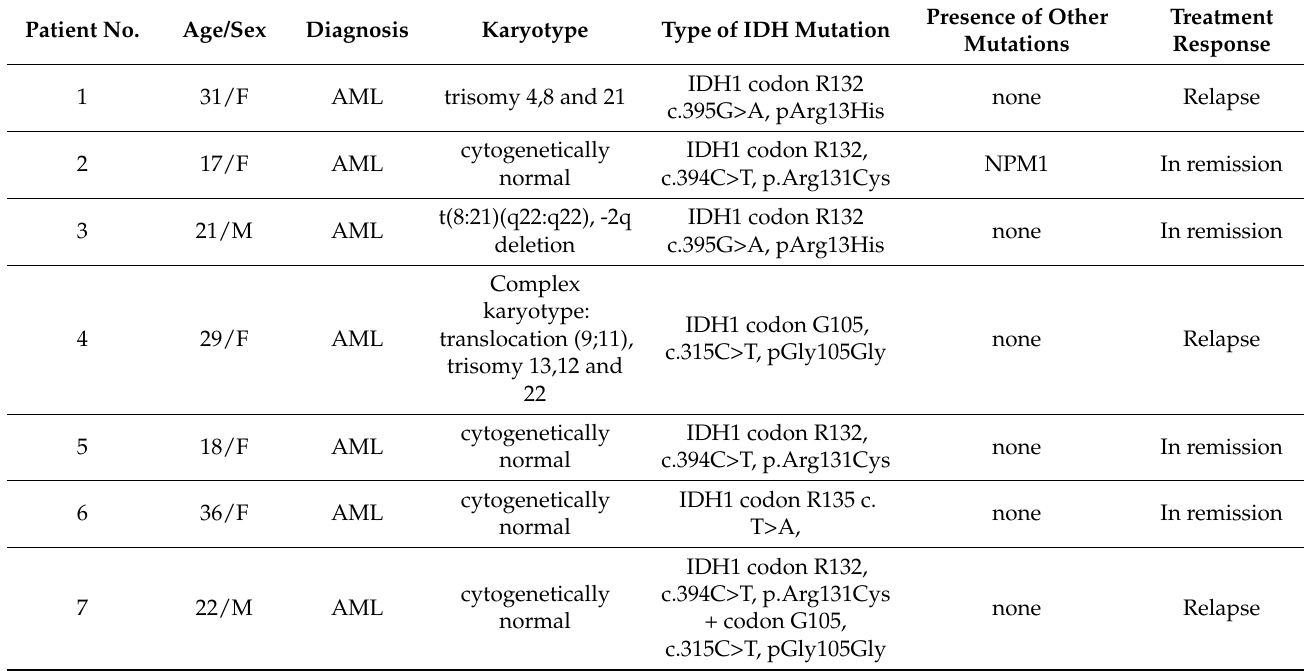
Table 3. IDH1/2 mutations in AML